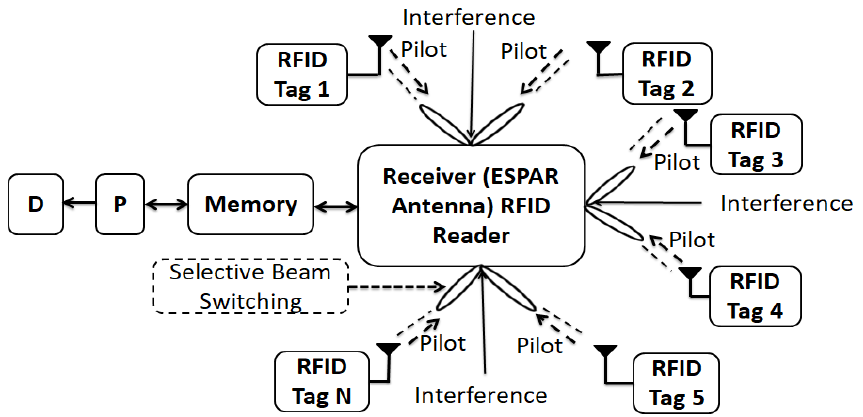
Figure 2. System configurations with central reader; D: display, P: